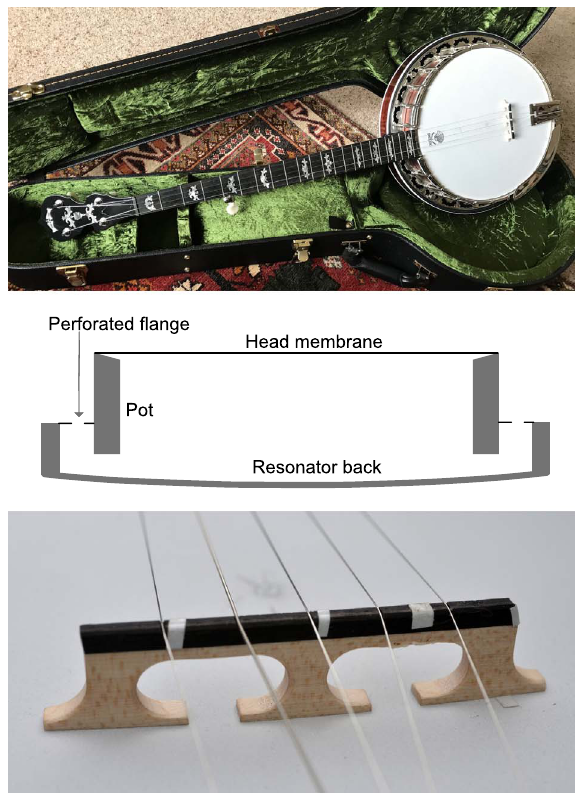
Figure 1. The Deering banjo, a schematic cross-section of the body with main components drawn approximately to scale, and a close-up of the bridge. The white patches on the bridge are re fl ective tape for the laser vibrometer measurements.